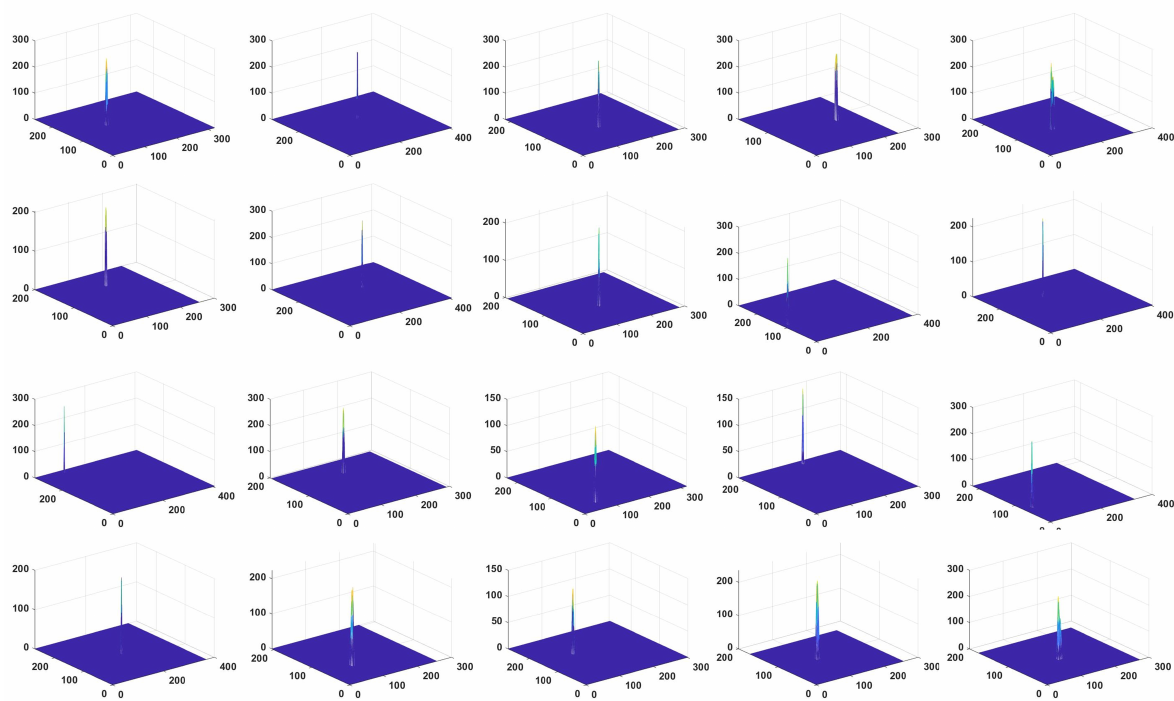
Figure 10. Three-dimensional results of the proposed method on the 20 single-frame